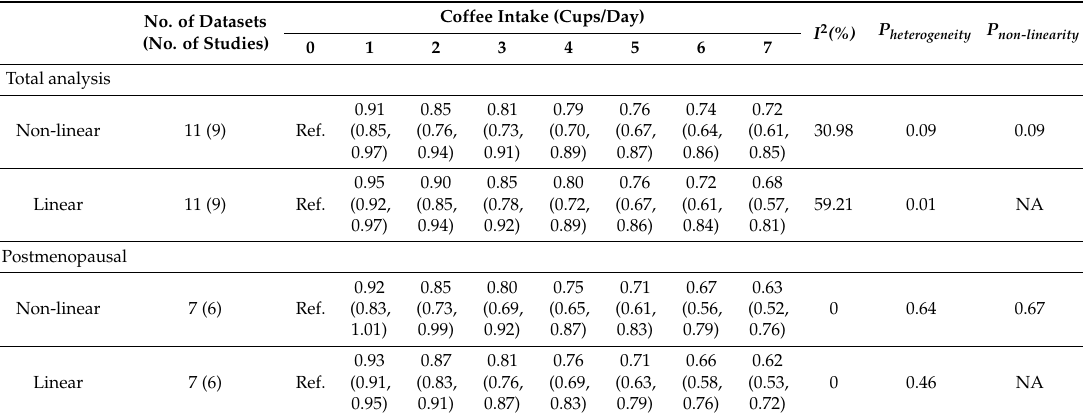
Table 3. Dose–response meta-analysis of prospective cohort studies on coffee consumption and endometrial cancer